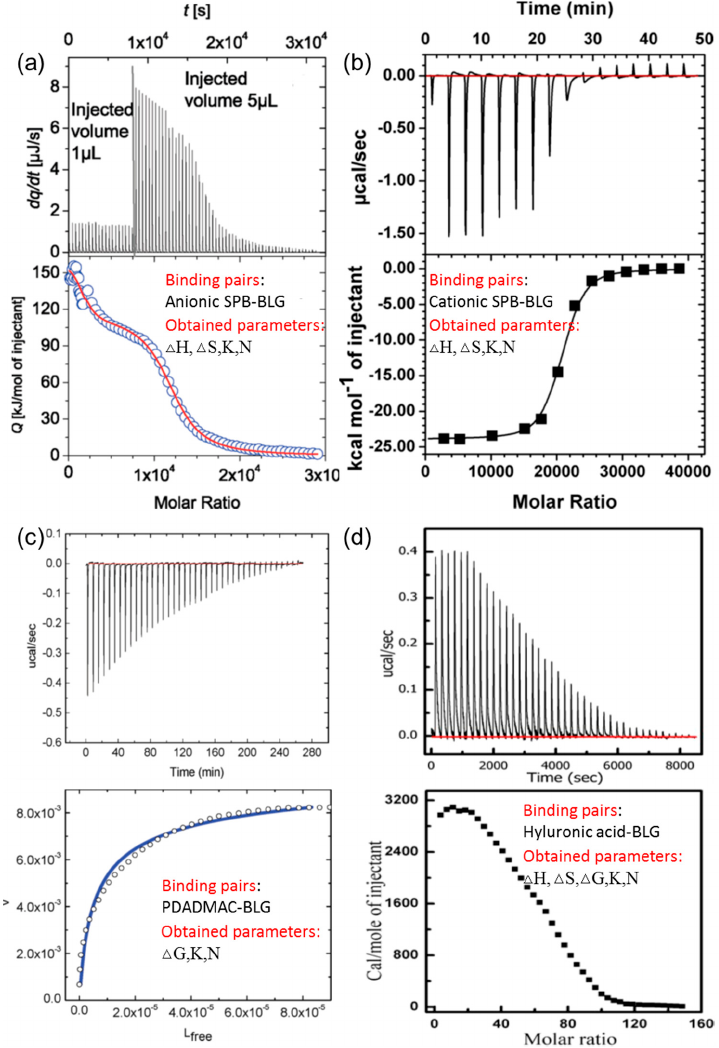
Figure 3. Typical isothermal titration calorimetry (ITC) data for binding of BLG with ( a ) anionic spherical polyelectrolyte brushes (SPB), ( b ) cationic SPB, ( c ) poly(dimethyldiallylammonium chloride)(PDADMAC), and ( d ) hyaluronic acid. Figure 3 was taken from the works of [28,30,32,47].